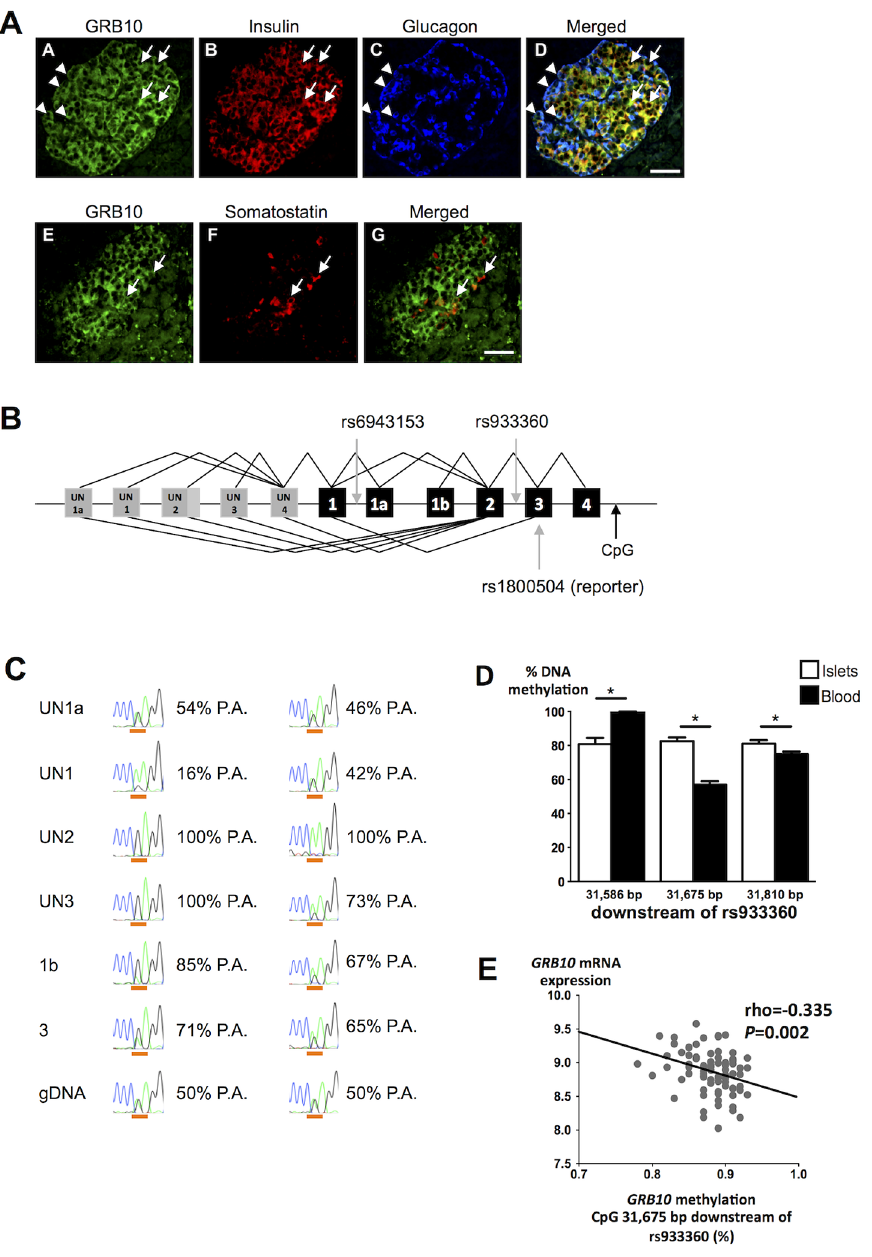
Figure 3. GRB10 expression in human islets. (A) Immunostainings demonstrating that GRB10 (green, panel A, E) is abundantly expressed in b - (panel B, D), a - (panel C, D) and d -cells (panel F, G) in human pancreatic islets. Arrows indicate co-localization with insulin (panel D) and somatostatin (panel G). Arrowheads indicate co-localization with glucagon (panel D). Scale bar=50 m m. (B) Schematic representation of the GRB10 gene and SNPs investigated in the present study. Grey boxes=untranslated exons. Black boxes=translated exons. (C) Examples of RT-PCR on islet cDNA (top six rows) and PCR on genomic DNA (gDNA, bottom row) from two individuals heterozygous for the reporter SNP rs1800504. The first column states the forward primer location of each PCR and a forward primer in exon 3 captures all transcripts. The peaks show the Sanger sequencing trace across rs1800504, which is underlined (A: green trace, G: black trace). Percentages indicate the contribution from the paternal allele (P.A.) (G-allele in the first case, A-allele in the second case). The paternal genotype is identified assuming complete maternal imprinting of the UN2 promoter, in line with previous findings [12]. A sequence of heterozygous genomic DNA (gDNA) is shown on the bottom for comparison (50%-50%). (D) To study if DNA methylation of GRB10 is tissue-specific, the degree of methylation was analyzed at 3 CpG sites located , 31.7 kb downstream of rs933360 in both human pancreatic islets of 98 donors and PBL from 6 trios using EpiTYPER. The exact position of each analyzed CpG site in relation to rs933360 is given in the figure. Data are presented as mean 6 SEM. * p , 0.05 for difference in methylation between human islets and PBL. (E) The GRB10 mRNA levels correlated negatively with the degree of methylation at the CpG site located 31,675 bp downstream of GRB10 rs933360.